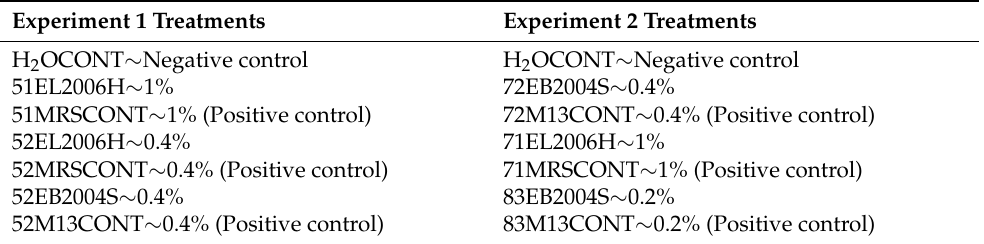
Table 3. List of CFS factor treatments used during greenhouse experiments for potato (except for the negative control, the first number for each treatment indicates the pH of origin; names of the strains are coded by EB2004S and EL2006H for B. subtilis and L. helveticus , respectively; MRS and M13 stand for medium